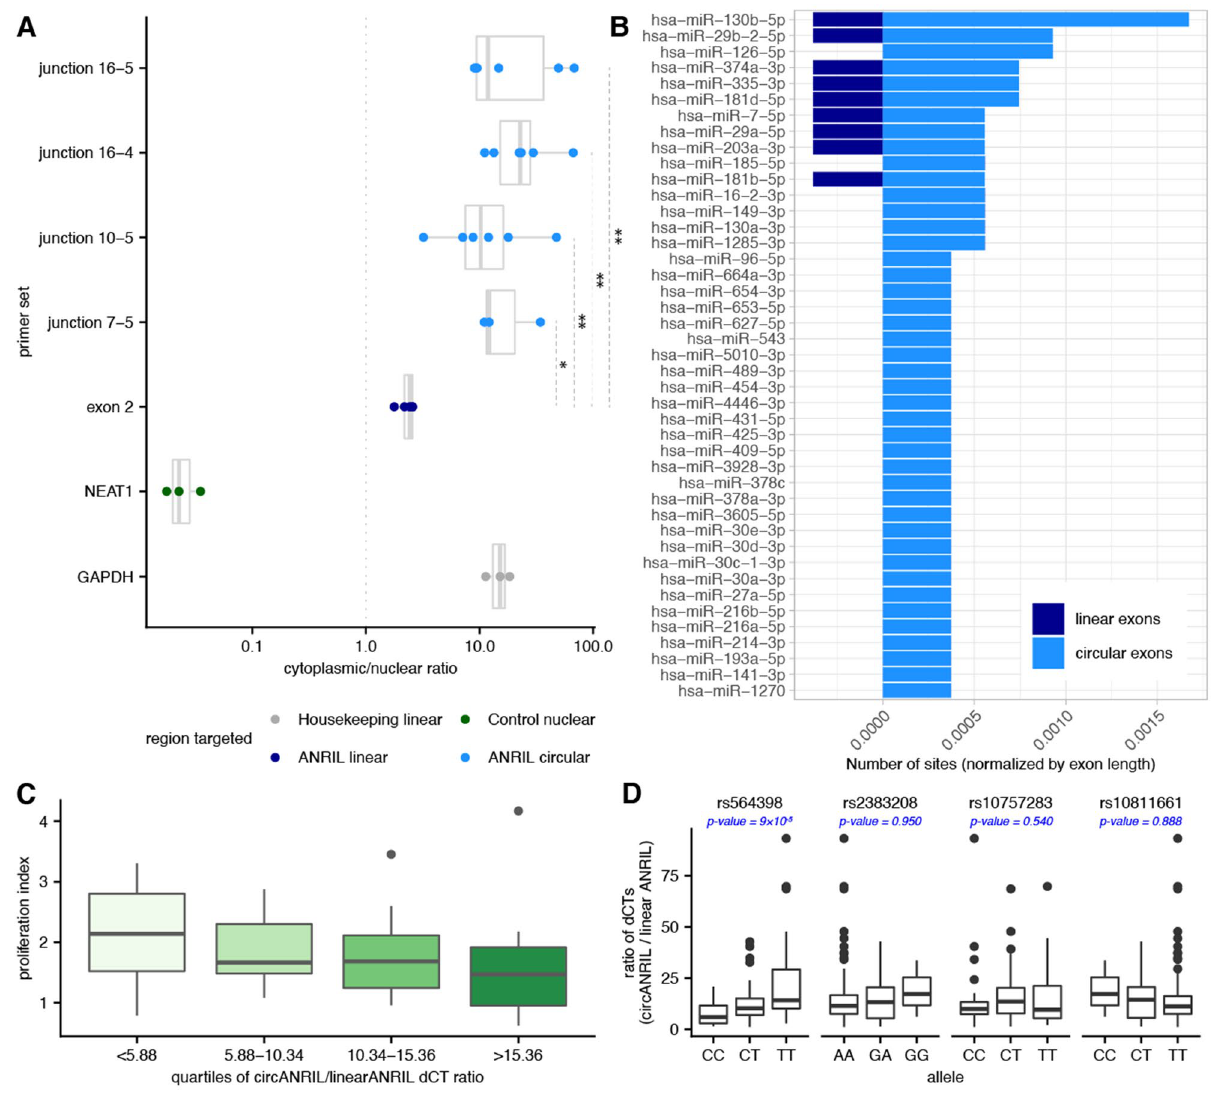
Figure 4. circ ANRIL is associated with cytoplasmic functions. ( A ) Ratio of cytoplasmic to nuclear abundance ( x-axis ) as measured by RT-PCR quantification with primer sets targeting a housekeeping gene ( grey ), a nuclear control gene ( green ), lin ANRIL ( light blue ) and circ ANRIL junctions ( dark blue ). ( B ) Number of miRNA target sites (normalized by exon length, x-axis ) in ANRIL circular exons ( light blue ) vs ANRIL linear exons ( dark blue ) for miRNAs with more sites in circ ANRIL exons. ( C ) Distribution of proliferation indices ( y-axis ) for quartiles of circ ANRIL /lin ANRIL ratios ( x-axis ) as measured by RT-PCR across 45 islet preparations. ( D ) Association between genotypes and circ ANRIL /lin ANRIL ratios for 4 disease-associated SNPs at the ANRIL locus across 122 islet preparations. P-values are computed from a linear regression and Benjamini–Hochberg circ ANRIL isoforms were predominantly cytoplasmic, with tenfold greater abundance in the cytoplasm on aver- age than in the nucleus (Fig. 4A). Cytoplasmic to nuclear ratios of circ ANRIL were also significantly higher than linear ANRIL (all Mann–Whitney U p -values < 0.05), which was approximately equally abundant in the nucleus and cytoplasm. circRNAs that are abundant in the cytoplasm have been previously implicated as cellular sponges acting to sequester RNA binding proteins (RBP) or miRNAs away from other regulatory targets 49,53,54 . Since we had not found any cytoplasm RBP motifs in circ ANRIL exons, we turned our attention to miRNA target sites. We looked for the presence of miRNA target sites in ANRIL exons frequently used in circ ANRIL isoforms (both participating in BSJs or internal exons) relative to exons more frequently seen in linear ANRIL , conditioning on miRNAs that are expressed in islet cells (mean RPM > 5 in the miRmine database; Methods). We find 43 miR- NAs with more target sites in circ ANRIL exons than in lin ANRIL exons, while only 18 have more target sites in lin ANRIL exons (normalized by respective total exon lengths, Figs. 4B, S4A; Table S6). It is important to note, however, that the total length of exons present in circ ANRIL is approximately double the length of exons present exclusively in lin ANRIL , providing greater chances for miRNA target sites to occur purely by chance. Previous